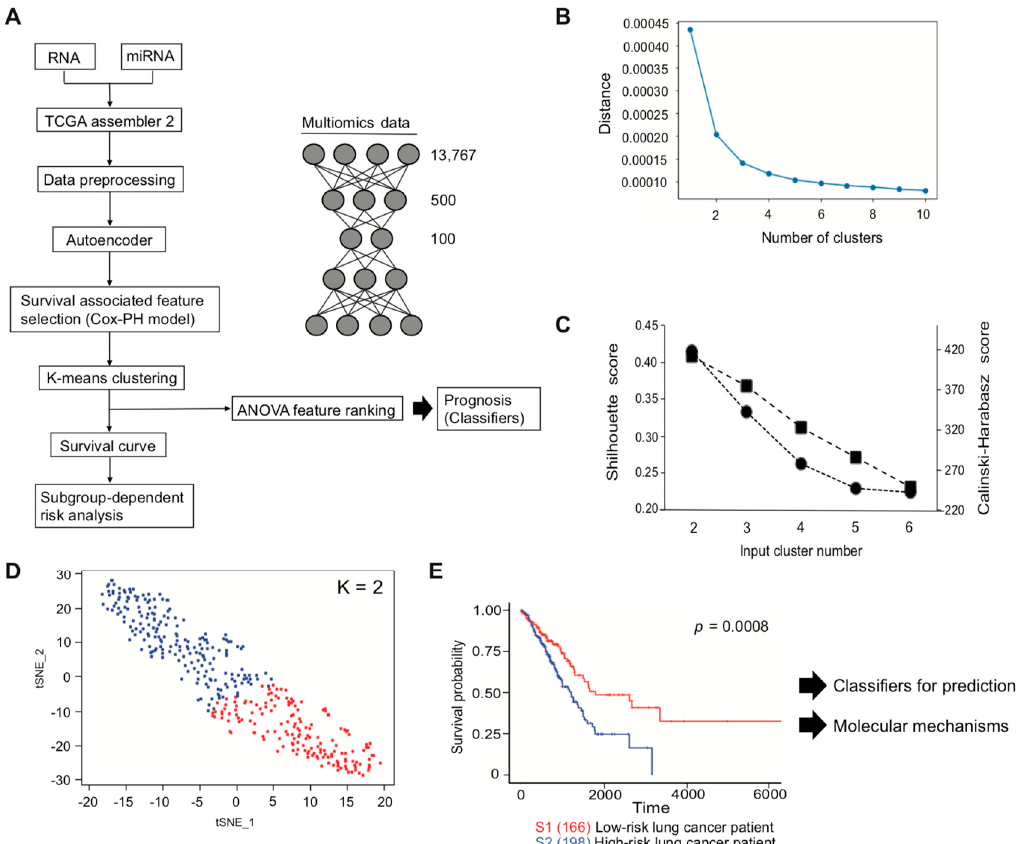
Figure 1. Overall workflow for classification of lung-cancer subtypes. ( A ) Multi-omics analysis pipeline. ( B ) Clustering result of elbow method. ( C ) Clustering results of the Silhouette index and Calinski–Harabasz criterion. ( D ) Clustering result of K-means clustering. Red dot represents S1, and blue dot represents S2 subtype in Figure 1E. ( E ) Kaplan–Meier plot using patient labels obtained from Figure 1D.